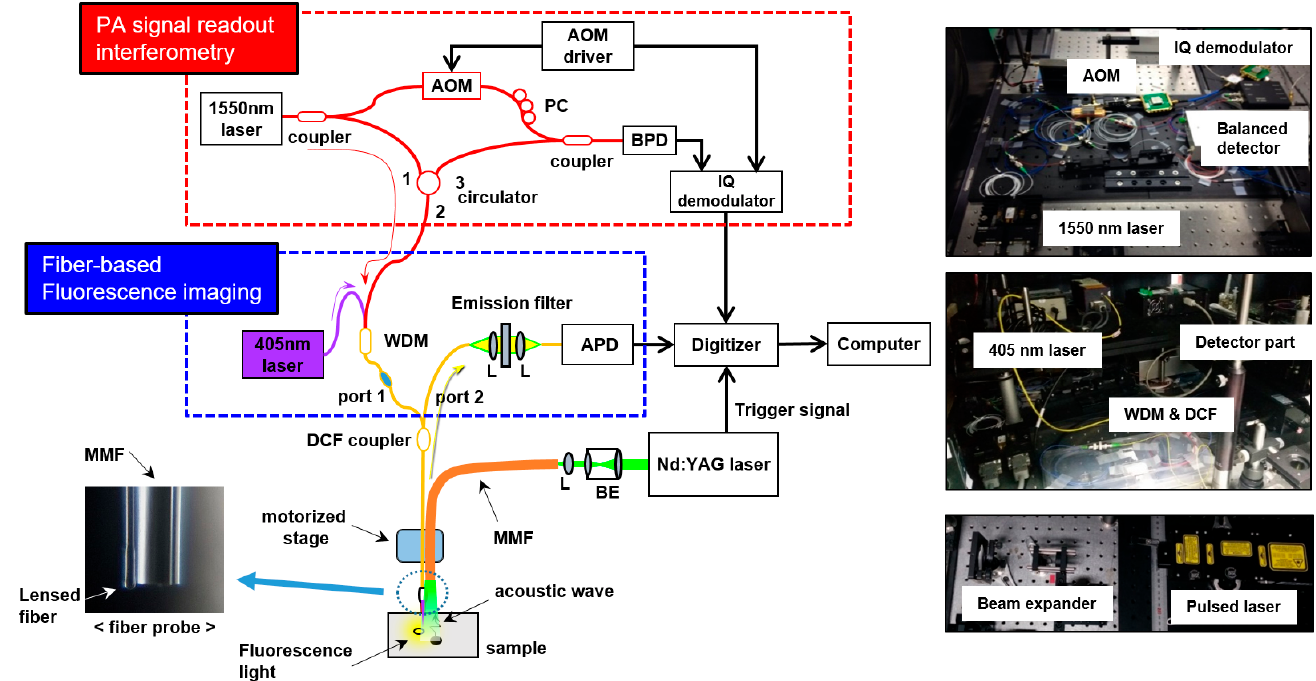
Figure 3. Schematic of the multimodal photoacoustic and fluorescence imaging system (WDM: wavelength division multiplexer, BPD: balanced photodetector, L: lens, BE: beam expander, PC: polarization controller, MMF: multimode fiber, and APD: avalanche photodetector).